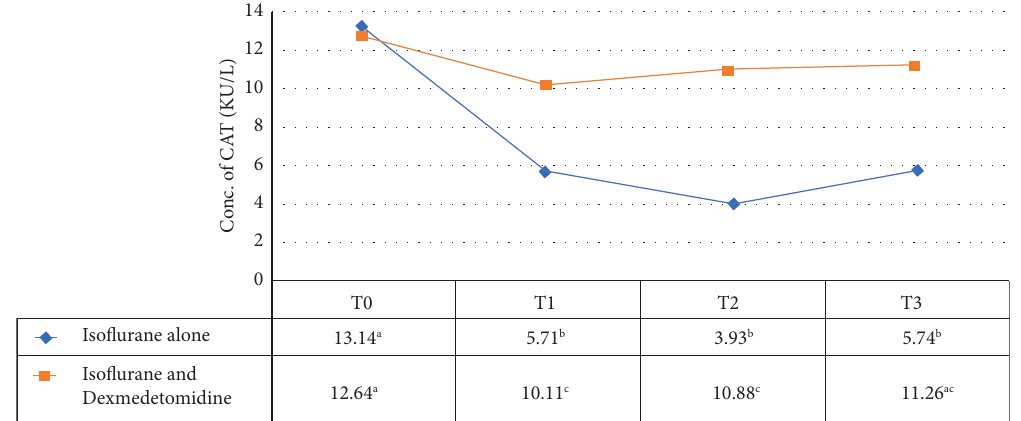
Figure 7: Comparison of CAT enzymatic activity (KU/L) in group A and group B. T T 1 � at 4hours after anesthesia induction. T 2 � at 8hours of anesthesia induction, T 3 � at 16 hours of anesthesia induction. Superscripts (a, b, and c) shows the statistical diference among diferent time intervals between two groups (repeated measures ANOVA).